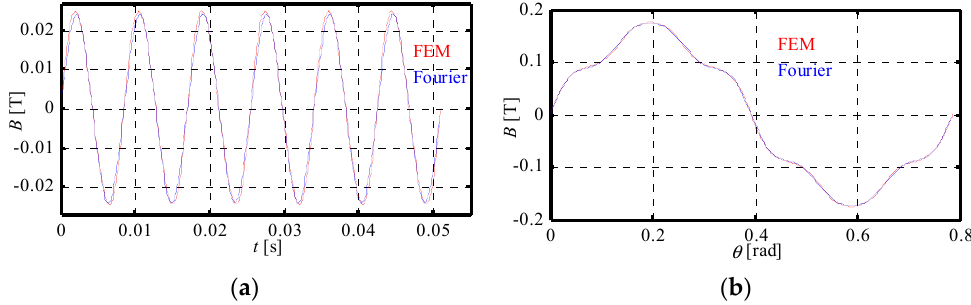
Figure 9. Flux density created by stator coils on the rotor surface of the Qs48p8 machine: ( a ) temporal distribution, ( b ) spatial distribution.